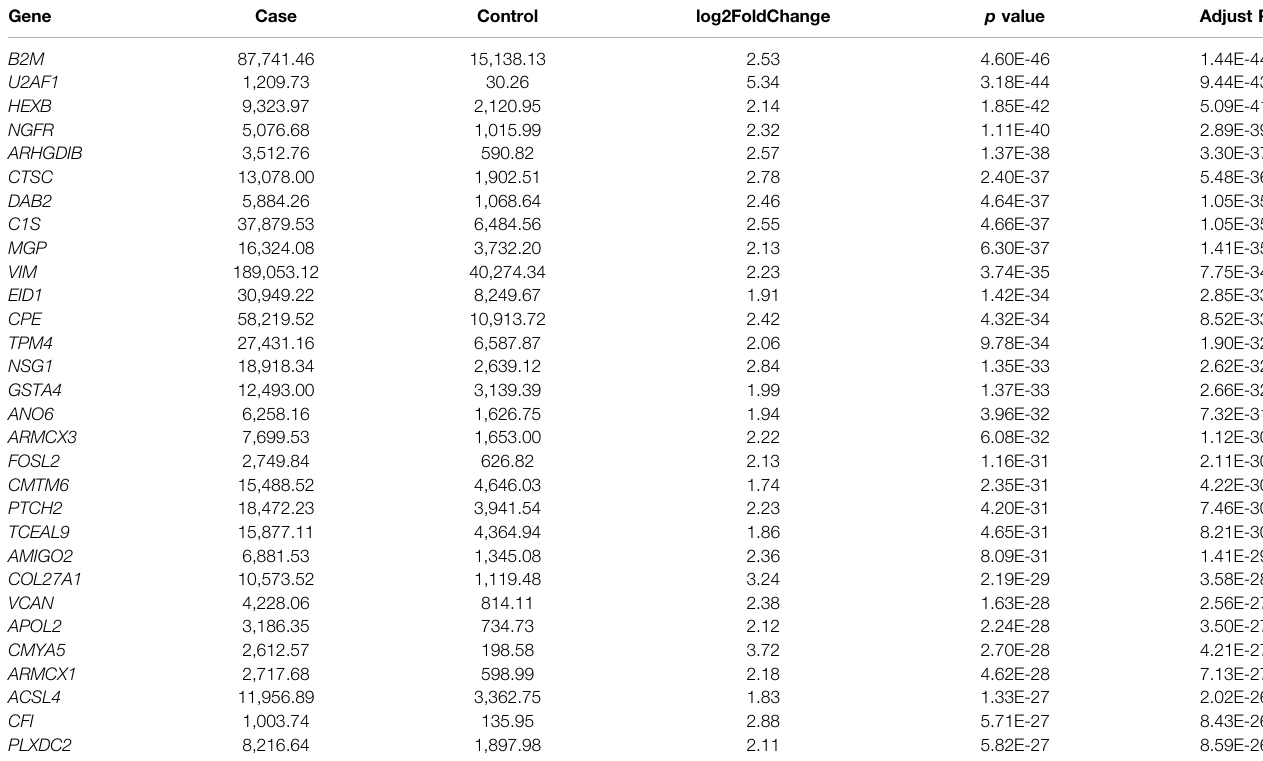
TABLE 5 | Top 30 most signi fi cantly upregulated genes in patients. Gene Case Control log2FoldChange p value Adjust